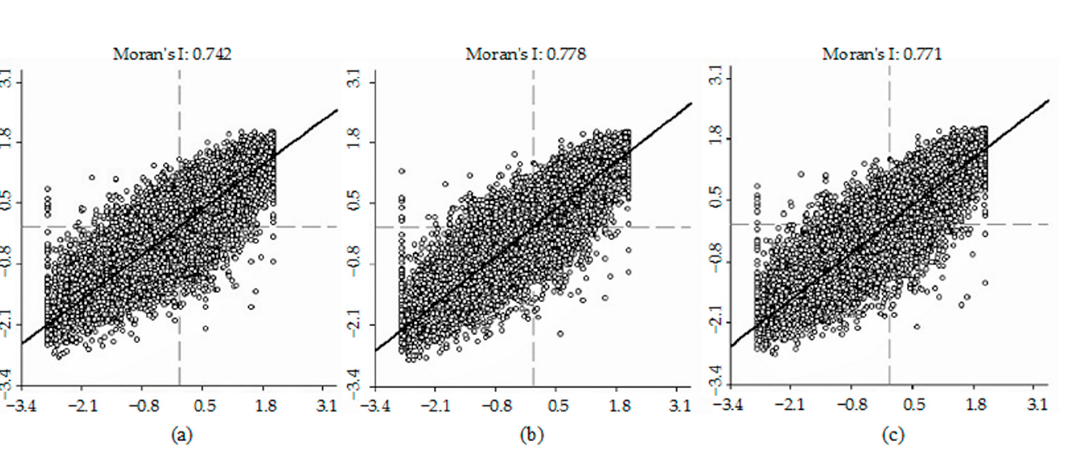
Figure 9. Scatterplot of Moran’s I index of habitat quality in 2020: ( a ) Queen-nearest neighbor; ( b ) Rook-nearest neighbor; and ( c ) K-nearest neighbor.